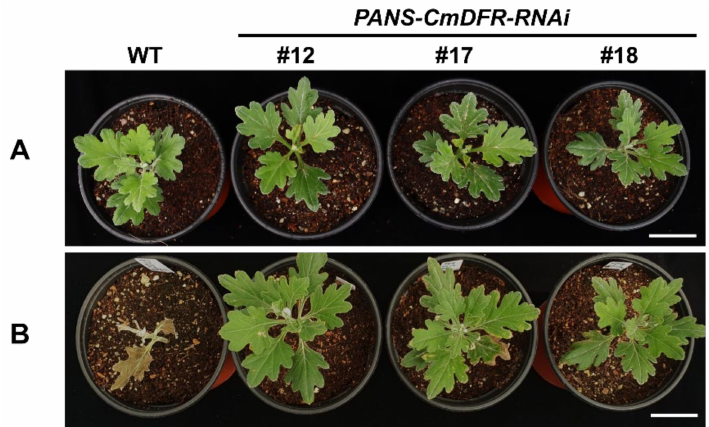
Figure 4. Effects of foliar spraying of 0.3% ( v / v ) Basta herbicide on putative transgenic chrysanthe- mum plants that were generated by several rounds of stem cutting propagation. Before ( A ) and after ( B ) herbicide application. The photos were taken 7 days after herbicide treatment. Bar = 4